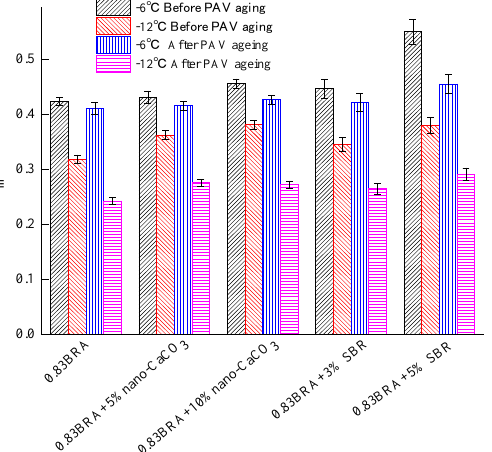
Figure 6. Creep stiffness S of nano-CaCO 3 /BRA and SBR/BRA compound-modified asphalt before and after pressure aging vessel (PAV) aging. Appl. Sci. 2018 , 8 , x FOR PEER REVIEW